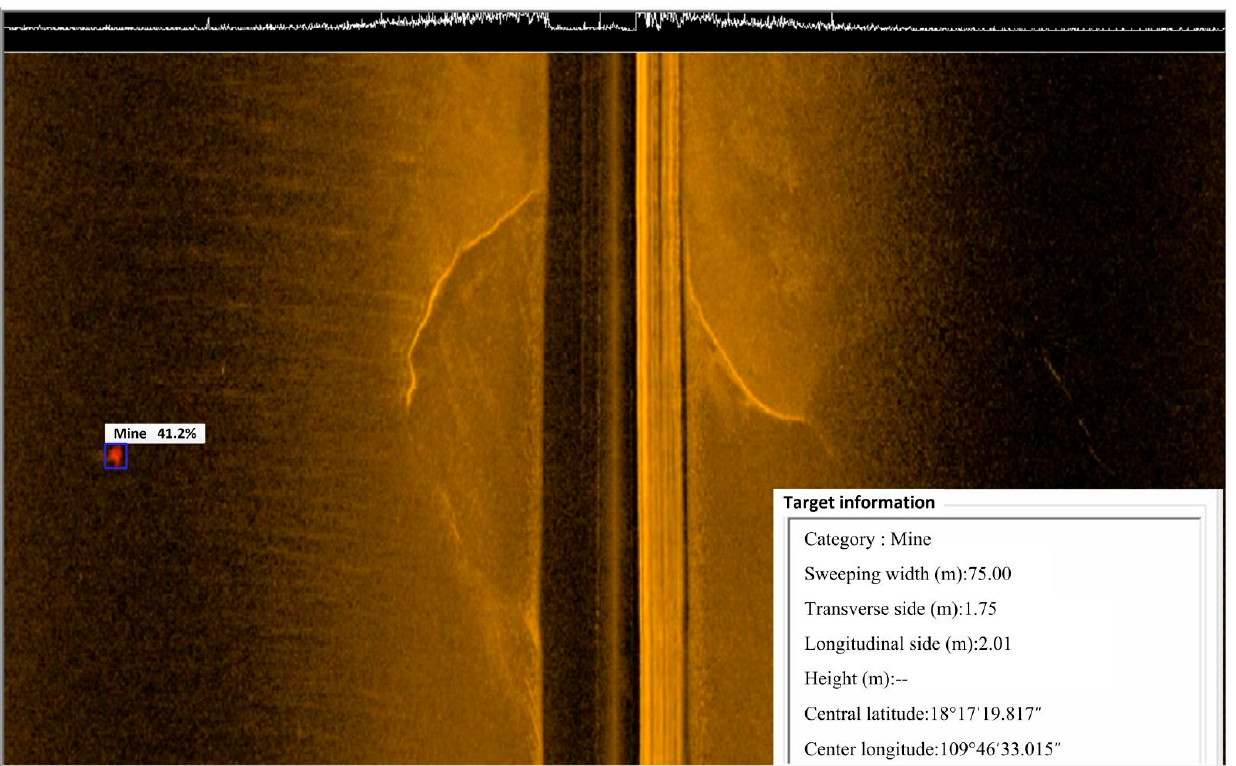
Figure 19. Key information transmission for the mine target.